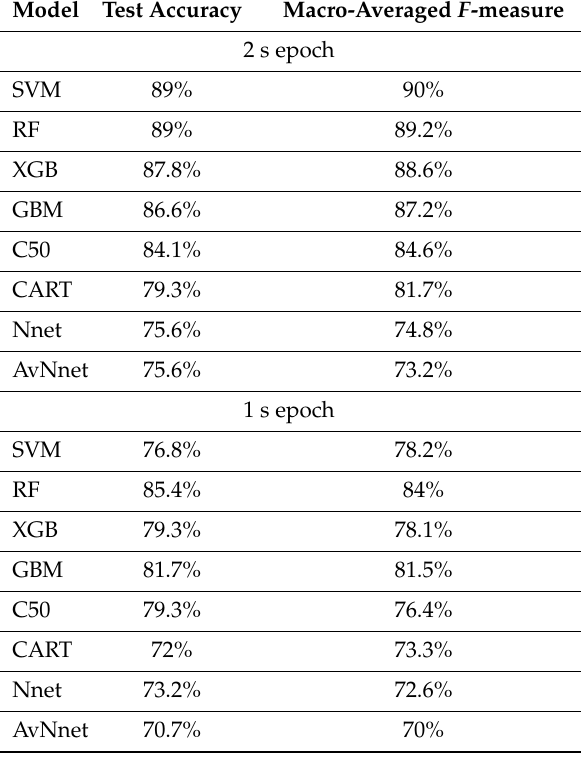
Table 5. Average (out-of-sample) test results of classification models for 1 and 2 s epochs.